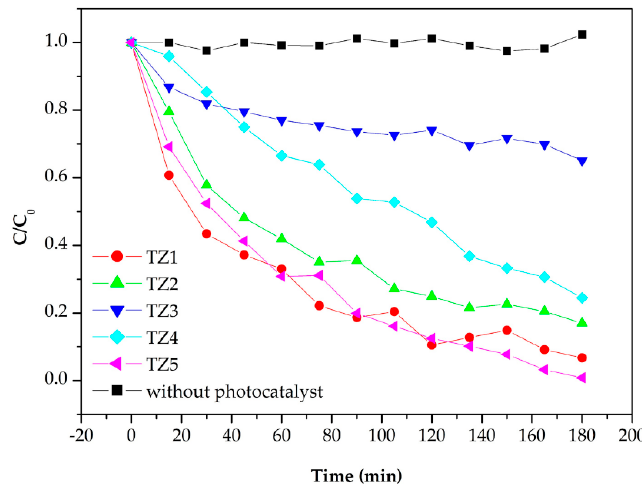
Figure 9. Photodegradation rate of methylene blue by various photocatalysts.